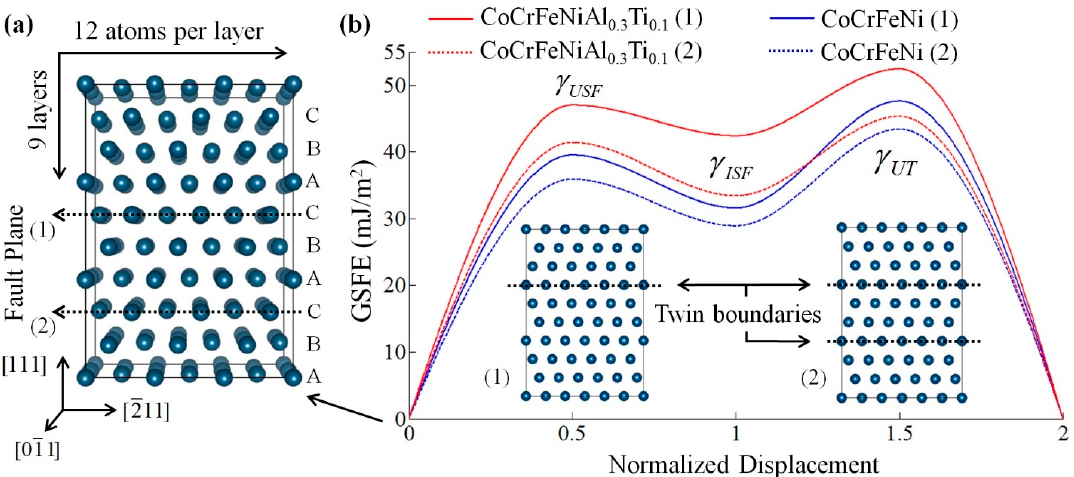
Figure 9. ( a ) fcc supercell structure used for calculating generalized stacking fault energy curves and surface energies of CoCrFeNi ‐ based single phase MPE alloys. ( b ) Calculated GSFE curves for CoCrFeNi and CoCrFeNiAl0.3Ti0.1 by considering two different fault planes shown in ( a ); subset pictures show twin boundary formation for these two cases (this figure is from Reference [109]).